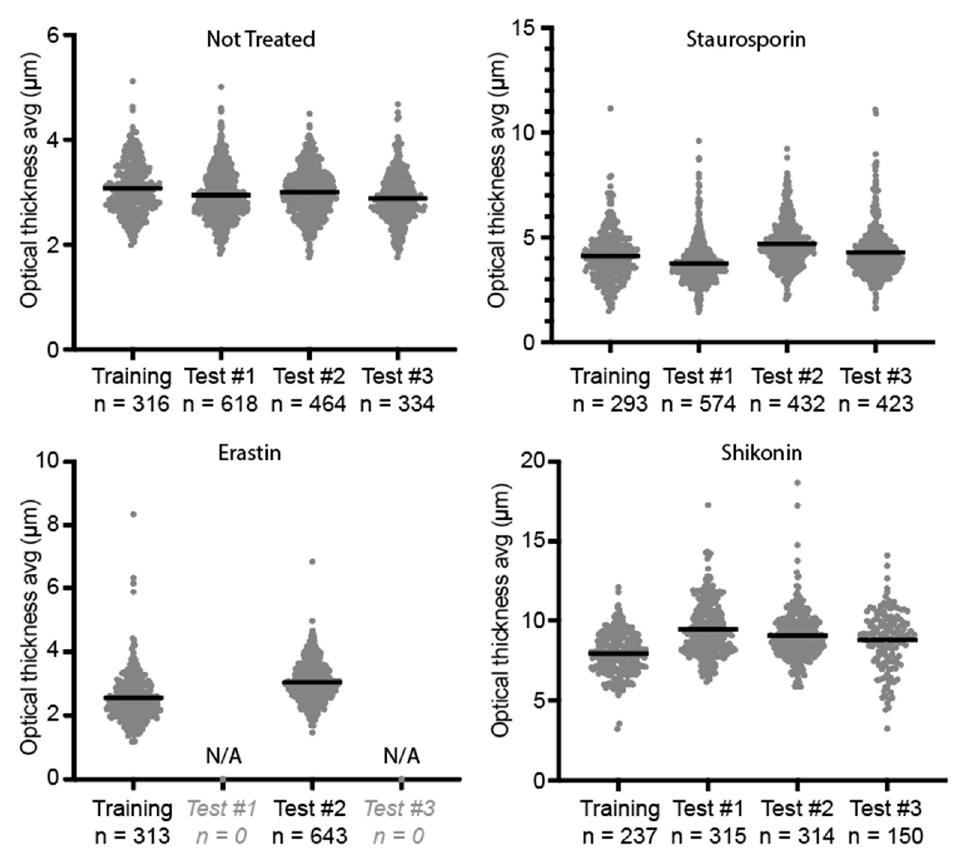
Figure 2. Distribution of average (ave) optical thickness per cell from indicated conditions across four experiments.